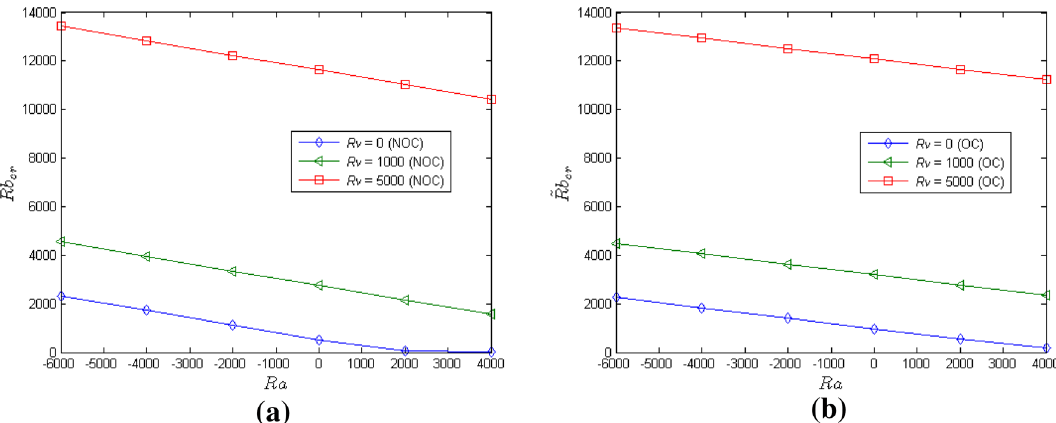
̃ Rb cr ) plane for